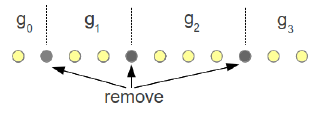
Figure 1. Partitioning eight items into four groups.